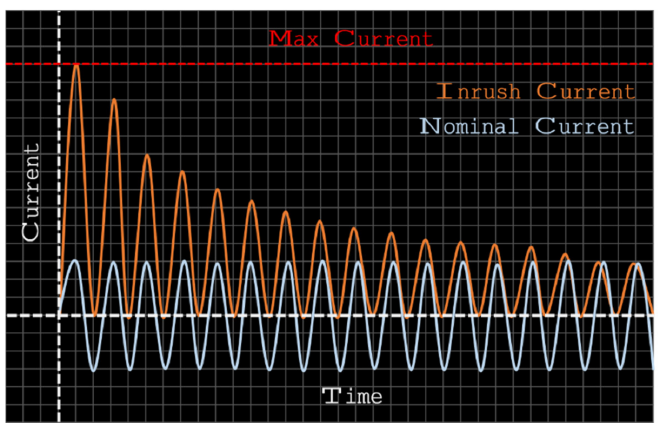
Figure 4. Waveform characteristic of the inrush